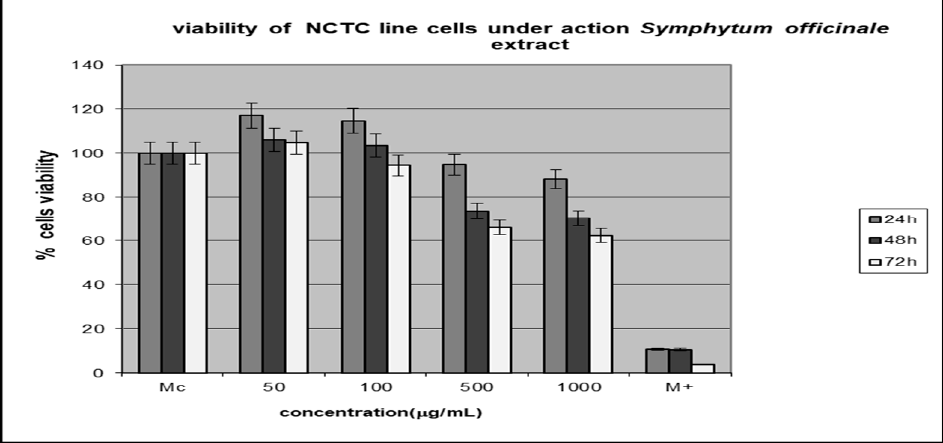
Figure 3. The viability of NCTC cell lines under action S. officinale extracts.